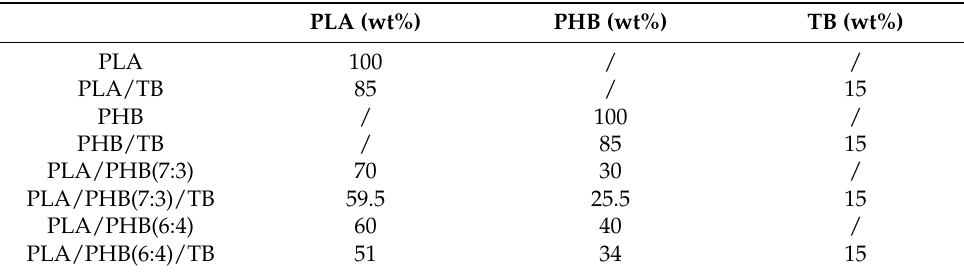
Table 1. Compositions of the obtained